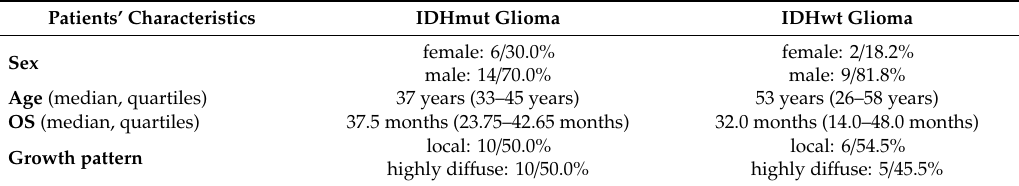
Table 2. Clinical parameters of IDHmut ( n = 20) and IDHwt glioma ( n = 11)